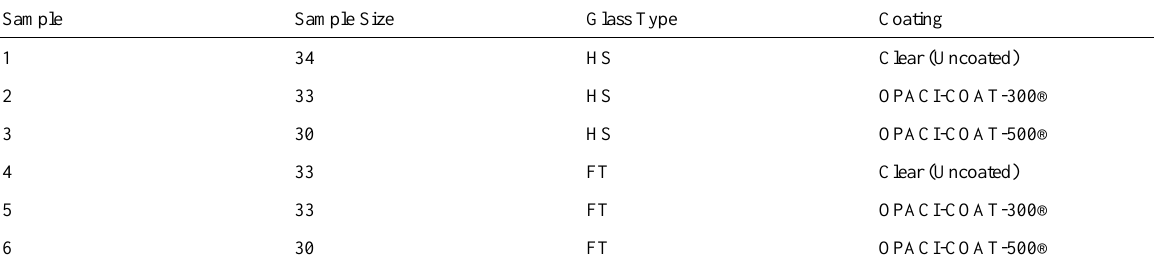
Table 1: Samples tested via four-point